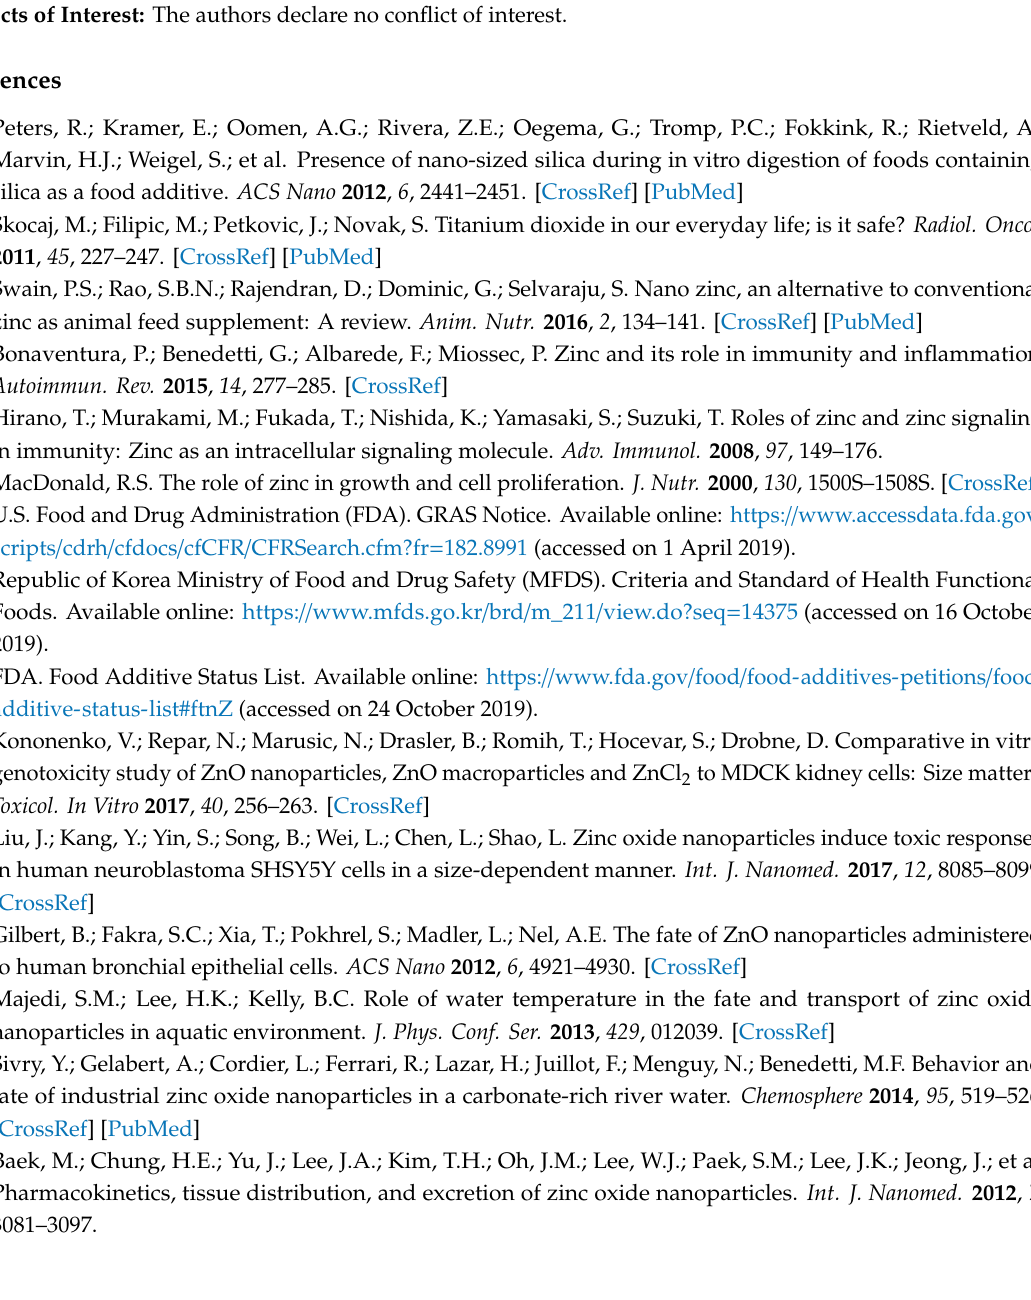
Figure S1: Hydrodynamic radii of pristine ZnO and ZnO obtained by CPE in ZnO-NP-spiked foods. Author Contributions: S.-J.C. conceived and designed the study, and wrote the manuscript; Y.-R.J. performed all experiments; J.Y. contributed to the discussion. All authors have read and agreed to the published version of the